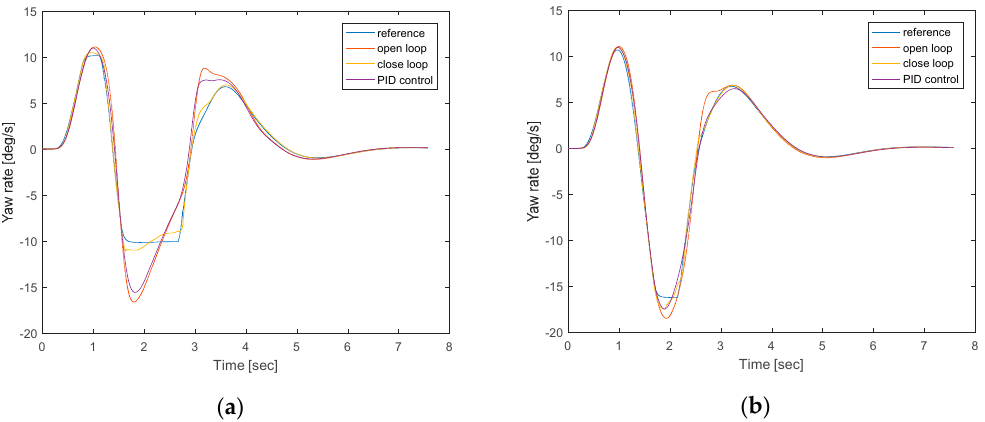
Figure 8. Comparison of yaw rate at 100 km/h with a coefficient of adhesion of 0.5 and 0.8. ( a , b ) reflect the nominal yaw rate, and yaw rate of three control methods at a speed of 100 km/h on a pavement with a pavement adhesion coefficient of 0.5 and 0.8.